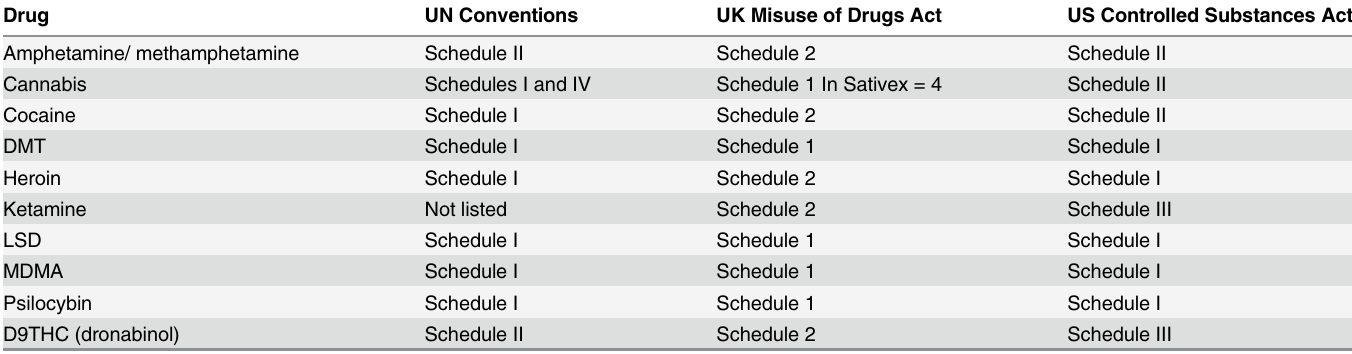
The UN and US Schedules use roman numerals, whereas the UK uses Arabic numbers. DMT = dimethyltryptamine. MDMA